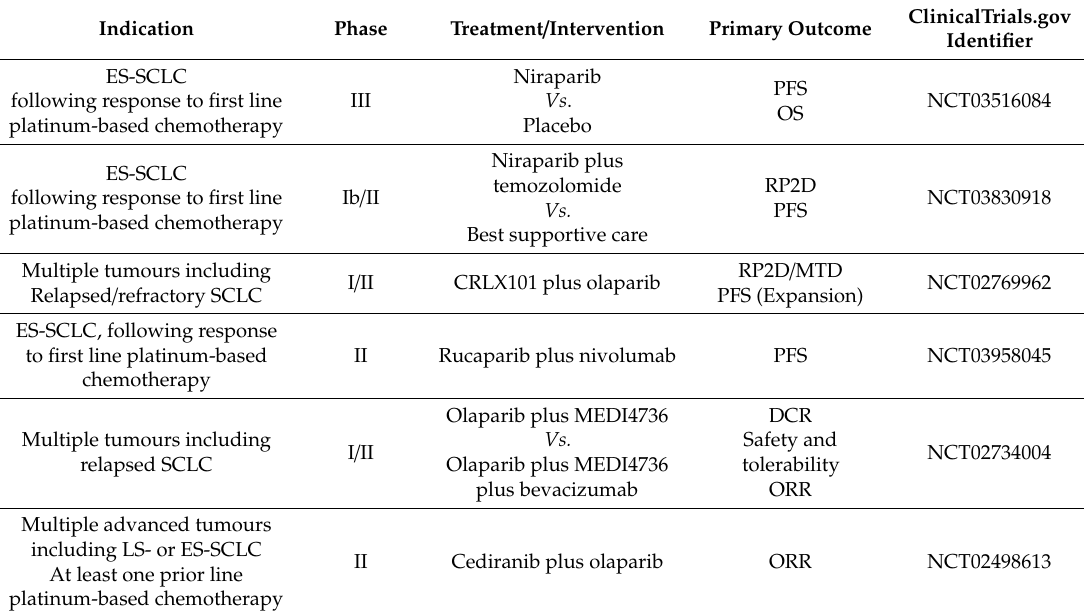
Table 1. Ongoing clinical trials of Poly (ADP-ribose) polymerase (PARP)inhibitors in small cell lung cancer